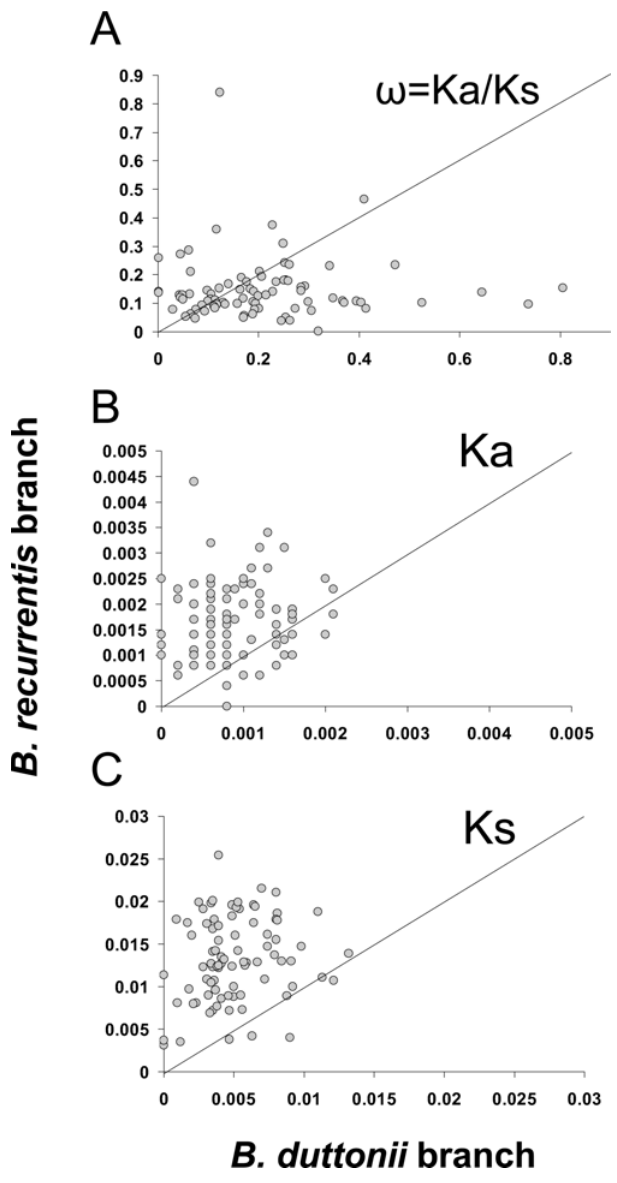
Figure 4. The v =Ka/Ks, Ka, and Ks values for B.recurrentis and B.duttonii branches. Seventy-seven 2190-codon alignments derived from the initial concatenated alignment of the borrelia core set were analyzed using model 2. Only values obtained for the B. recurrentis and B. duttonii branches are presented. The dot plots show v =Ka/ks (A), Ka (B), and Ks (C)